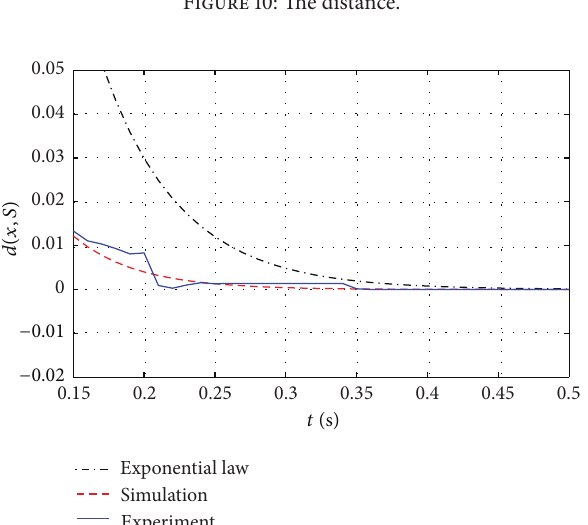
Figure 8: The sliding function 𝑐𝑥 .